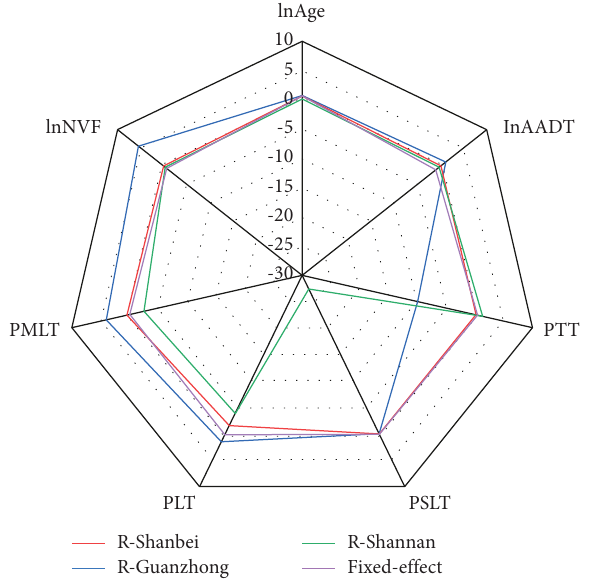
Figure 8: Regression coefcient of ridge regression and fxed-efect